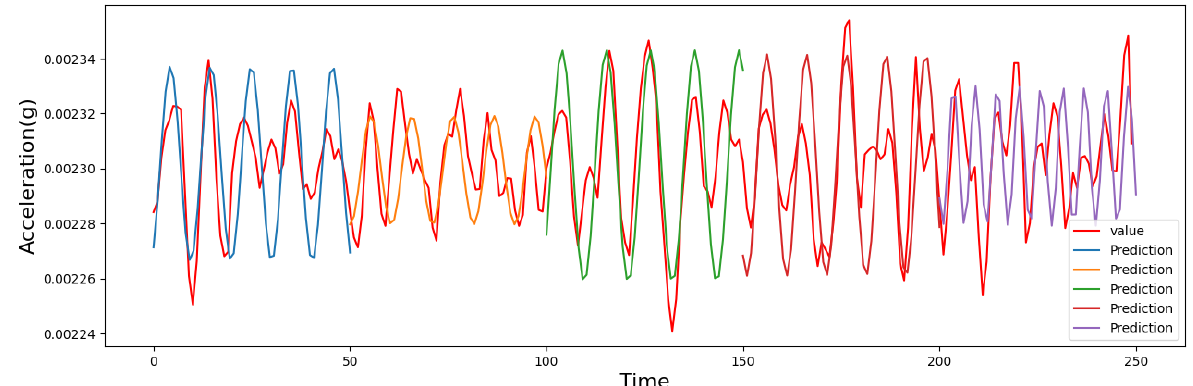
Figure 12. Structural state trend forecasting on the ASCE benchmark data set separated by half a year at different structure status.